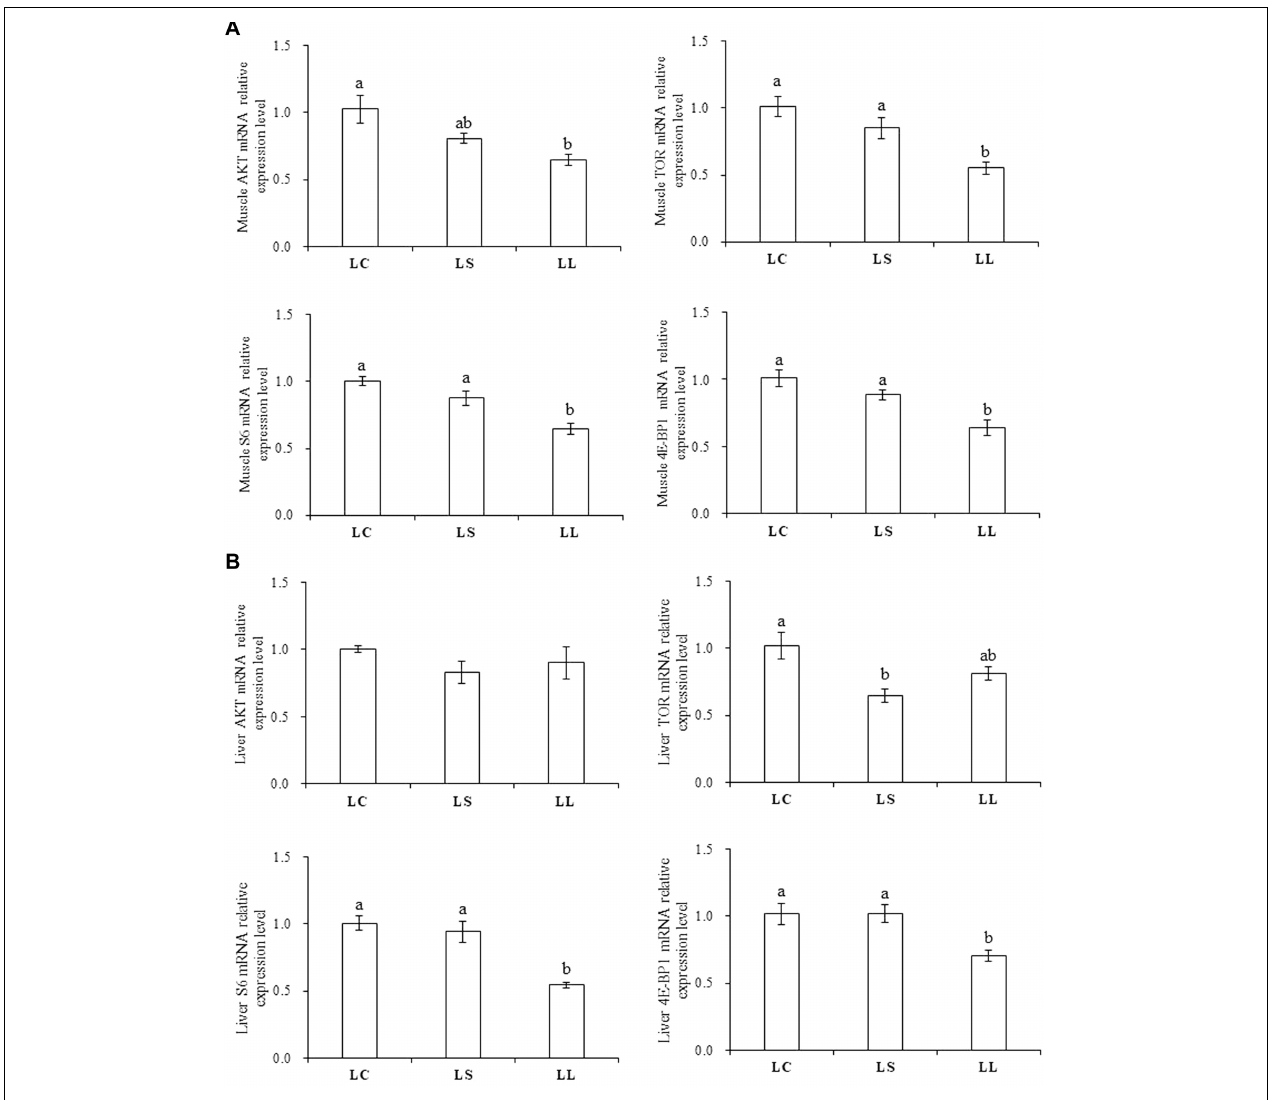
FIGURE 2 | Effects of the LC diet, LL diet supplemented with dietary lysine (LS diet) and the LL diet on muscle (A) and liver (B) mRNA expression levels of key regulators involved in TOR signaling pathway. Different superscript letters “a, b” indicated statistical significant differences ( P < 0 . 05; mean ± SEM, n =